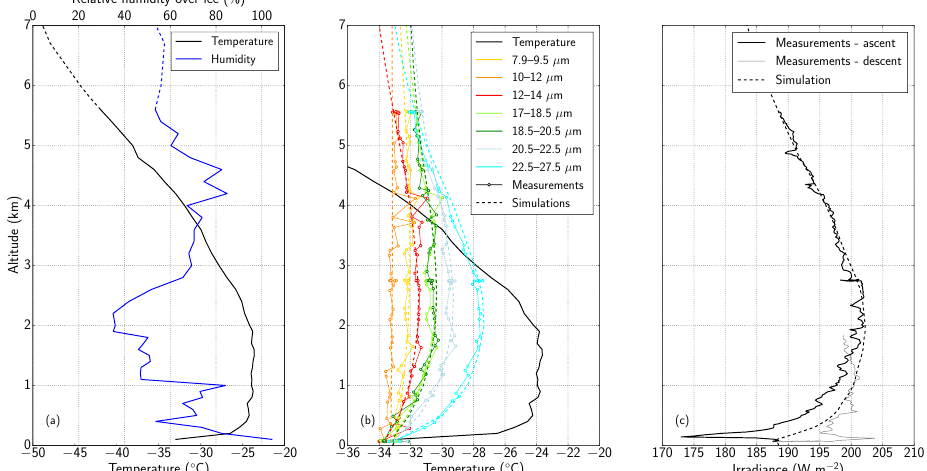
Figure 5. Vertical profiles of (a) temperature and relative humidity measured by in situ probes, (b) FIRR brightness temperatures and (c) upwelling broadband LW irradiance measured by the CGR-4 pyrgeometer for 11 April flight. The ascent portion correspond to the vertical profile and the descent portion shows the measurements taken 20 min prior to the ascent. The simulated FIRR brightness temperatures and LW irradiance are also shown. The 17.25–19.75µm band is not shown because it overlaps with others. The dashed lines in panel (a) correspond to the ERA-Interim profiles used for the simulations above maximum flying altitude.